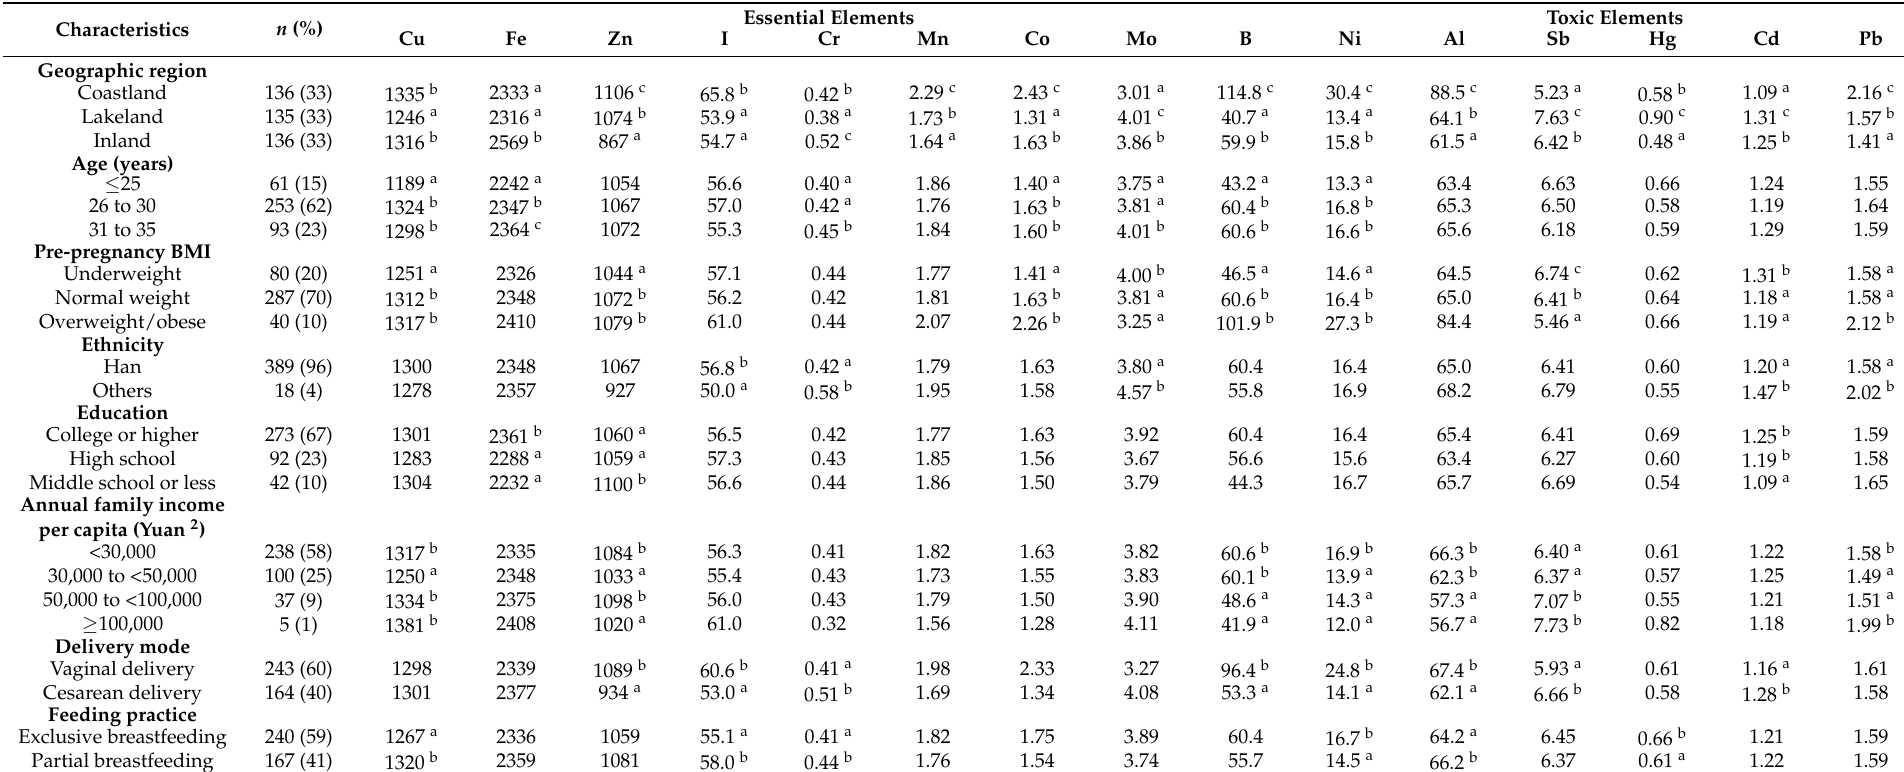
Table 3. Adjusted median concentrations (ng/mL) of plasma essential and toxic elements by characteristics of lactating women ( n = 407) 1